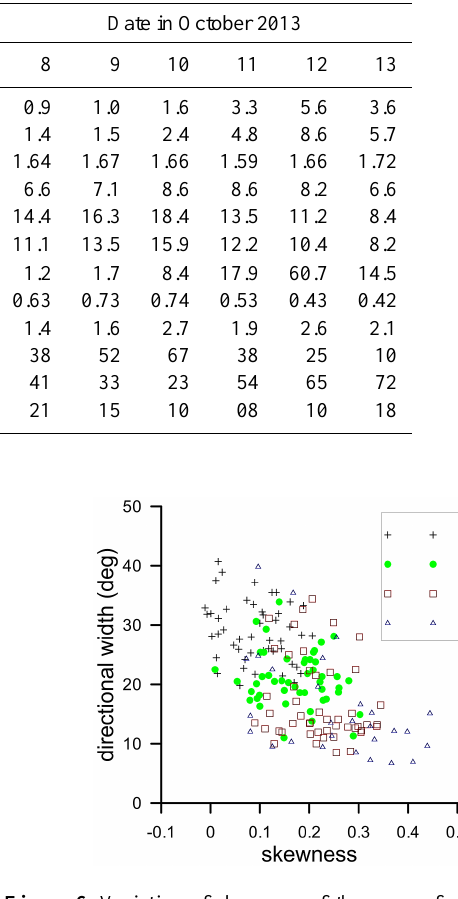
Figure 6. Variation of skewness of the sea surface elevation with directional width during 9–12 October